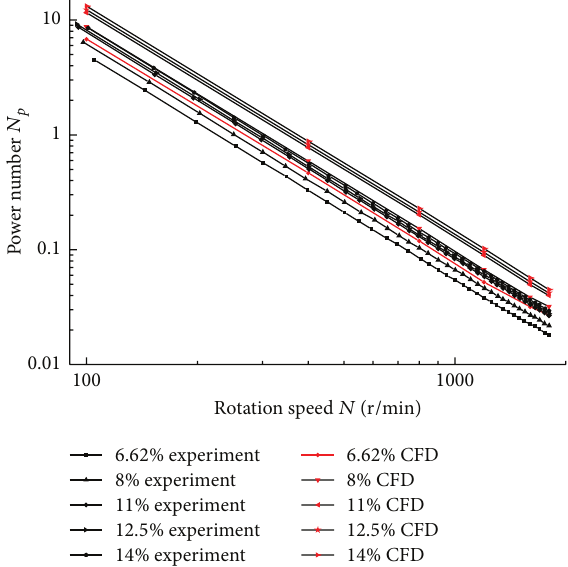
Figure 5: Comparison of CFD and experimental results for waste tissue pulp.